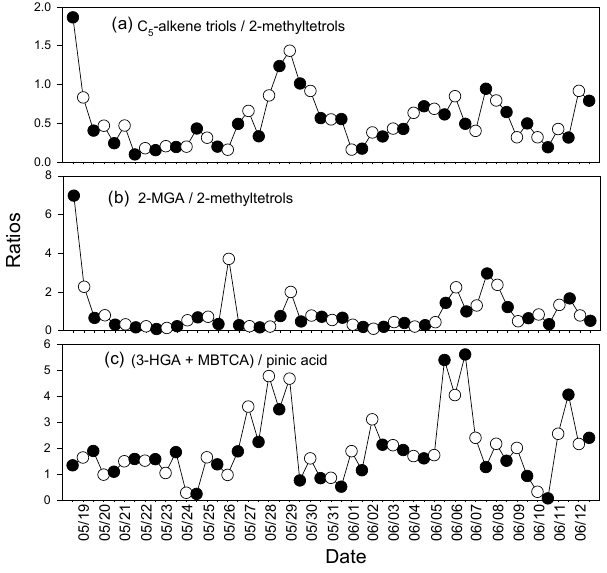
Figure 6. Temporal variations in the concentration ratios of iso- prene and α/β -pinene oxidation products in the marine aerosols over the East China Sea. The open and shaded circles represent day- time and nighttime samples,